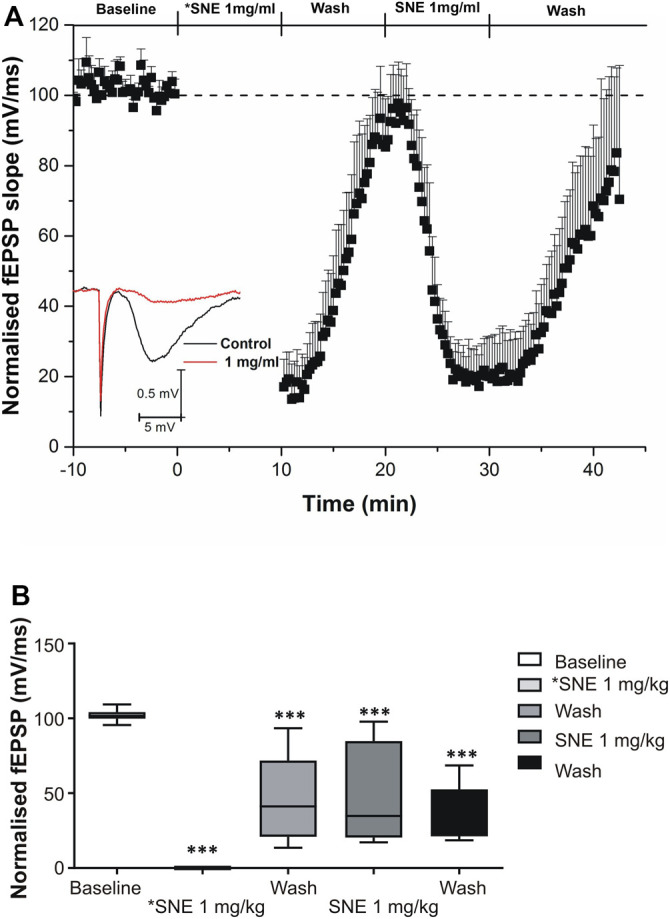

(A) Effect of SNE (1 mg/ml) on the slope fEPSPs without stimulation (*SNE 1.0 mg/ml) and with stimulation (SNE 1.0 mg/ml). (B) The box and whiskers graph is the total effect calculated form the AUCs of the graph above it. Data is mean ± SEM (n = 5). ***p < 0.001 compared with baseline, one-way ANOVA followed by a Dunnett’s multiple comparison test.